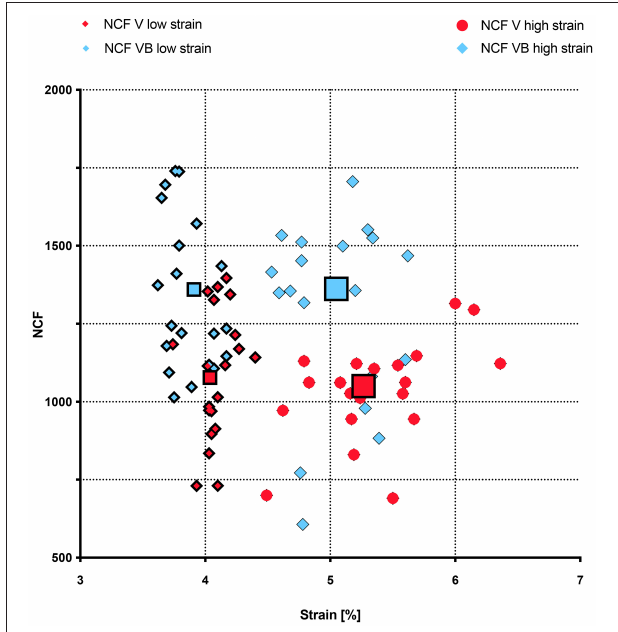
FIGURE 2 | Numbers of rotations to failure (NCF) plotted against strain values. Vortex data is shown in red, VB in light blue. Symbol size related to low strain (7.5mm radius) and large to high strain (5mm radius). Global group means and standard deviations are indicated.